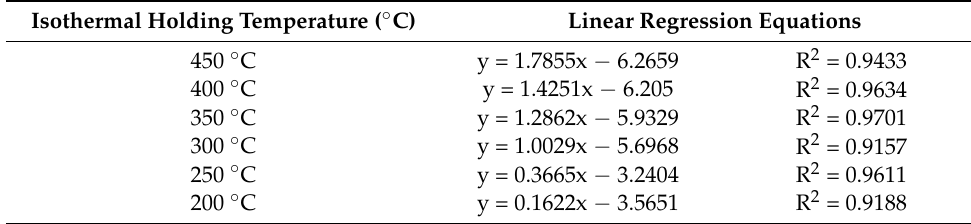
Figure 5. Plots of ln[ − ln(1 − x)] vs. lnt corresponding to dilatation data acquisitioned at various isothermal holding temperatures below M s : ( a ) 250 ◦ C and ( b ) 200 ◦ C. Table 1. Linear regression equations describing the dilatation behaviours at various isothermal hold- ing temperatures based on Avrami-type functions applied to the dilatation results in the temperature range 450–200 ◦ C.